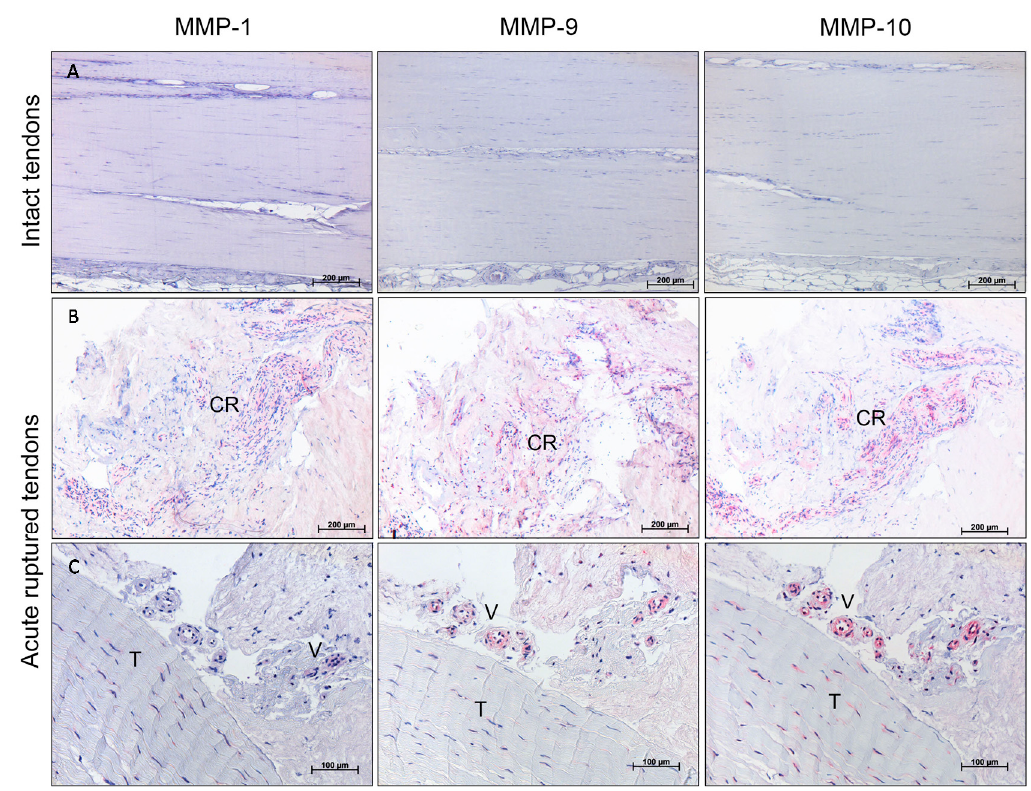
Figure 5. Exemplary results of immunohistological staining for MMP-1, MMP-9, and MMP-10 of representative areas of intact controls versus acute ruptured Achilles tendons (3-days-old ruptures). ( A ) Intact cadaveric tendons showed no MMP staining. Scale bar: 200 μ m. ( B ) Positive MMP staining of cell-rich areas (CR). Scale bar: 200 μ m. ( C ) Positive MMP-10 and slightly positive MMP-1 and MMP-9 staining of tenocytes (T) and positive MMP-9 and -10 and slightly positive MMP-1 staining around blood vessels (V). Scale bar: 100 μ m.